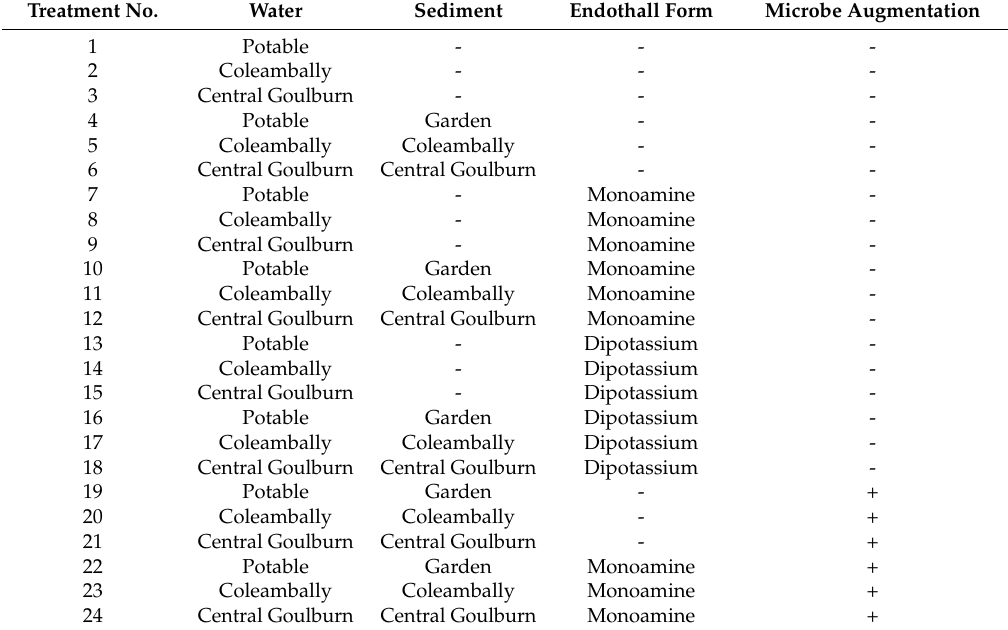
Table 1. Description of treatments (source of water; presence/absence and source of sediment;